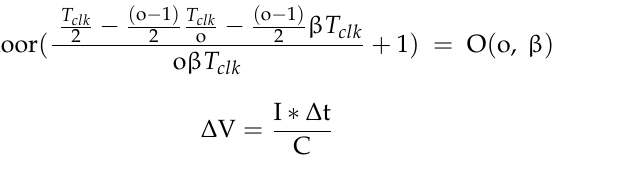
Figure 3. Timing diagrams of asynchronous sampling when α << 1, ( a ) α ≈ 1/3 (the odd-denominator case), and ( b ) α ≈ ¼ (the even-denominator case).